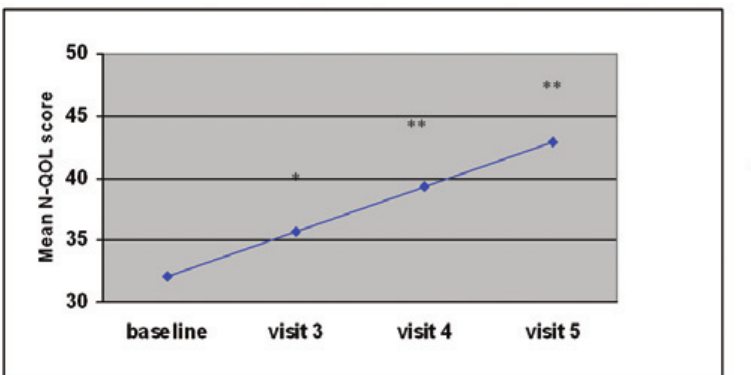
Figure 4 -Improvement in N-QOL (Items